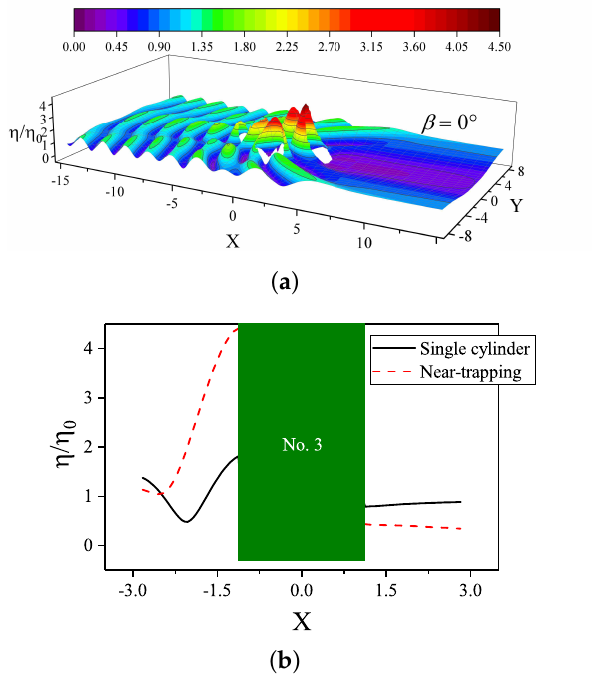
Figure 4. The dimensionless free-surface elevation at k 0 a = 1.68: ( a ) perspective view; ( b ) profile of the No. 3